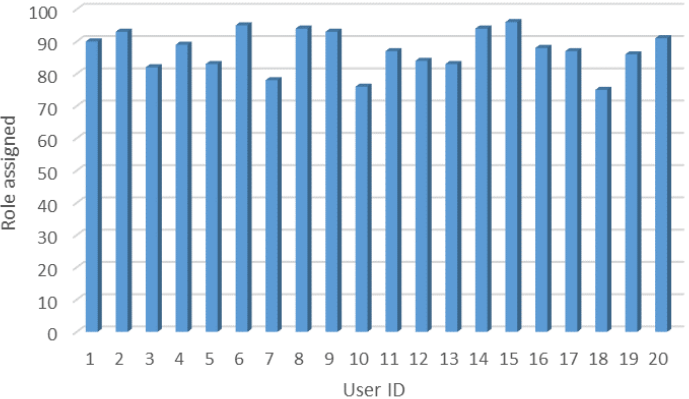
Figure 15. Assessment of the acceptance of the role assigned to the robot.